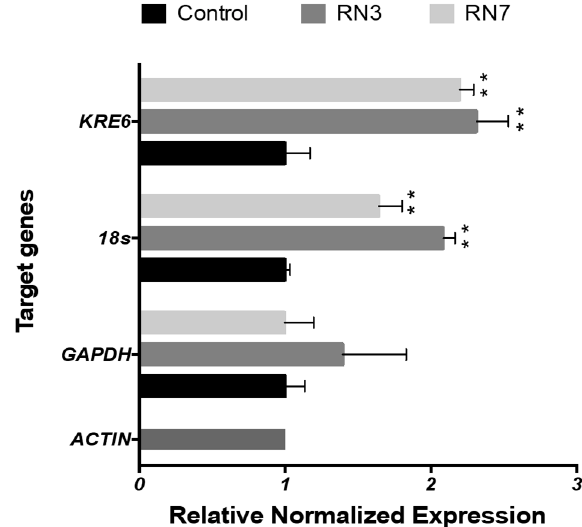
Figure 6. Gene expression profile in planktonic cells of C. albicans cells after treatment with 0.5 µ M of RN3 and RN7 during 120 min of incubation. The mean values are averaged from two independent experiments performed in duplicates. Statistically significant results were evaluated by ANOVA test, followed by Dunnett’s Multiple Comparison Test. Significant values are indicated respect to the non-treated cells (** p < 0.001); all the values are normalized in respect to ACTIN expression.